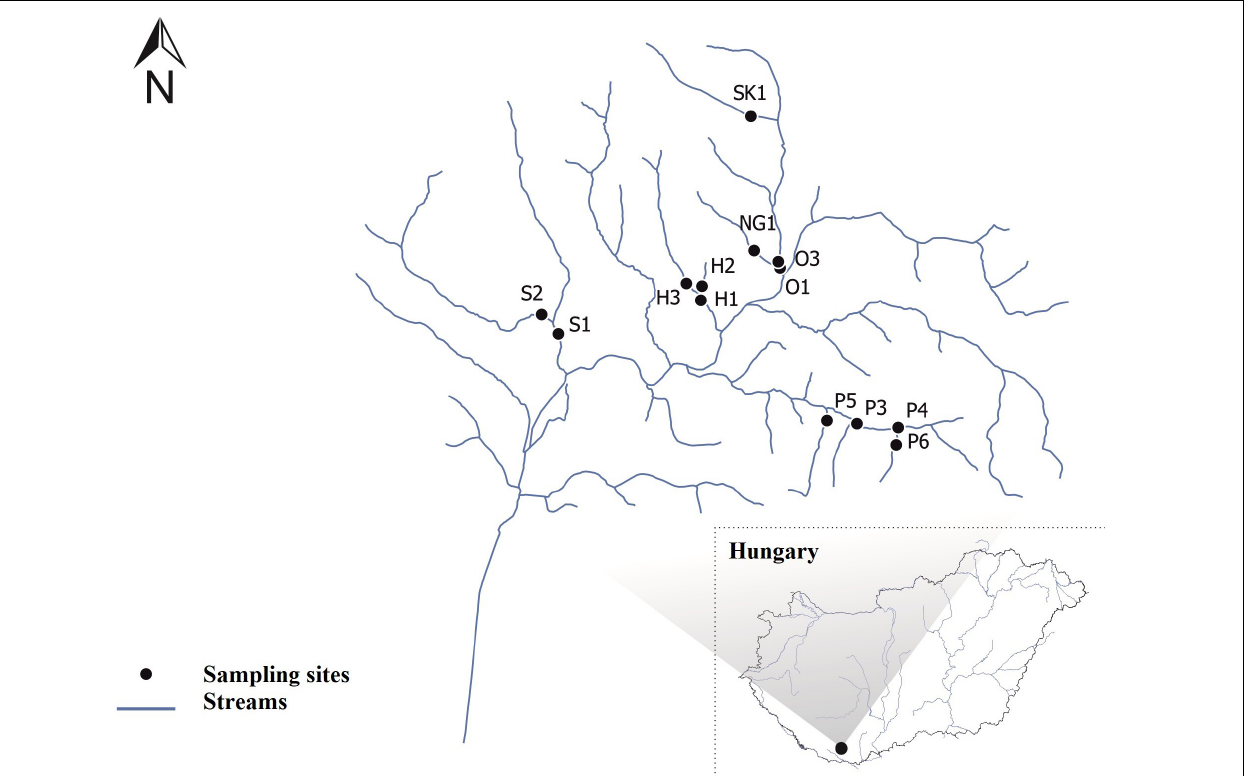
FIGURE 1 | Map of the study area in the Pannonian Ecoregion (Hungary), the watercourses are marked with blue lines. The sampling sites were marked with black circles. Abbreviations of sampling sites are found in Supplementary Table 1 .